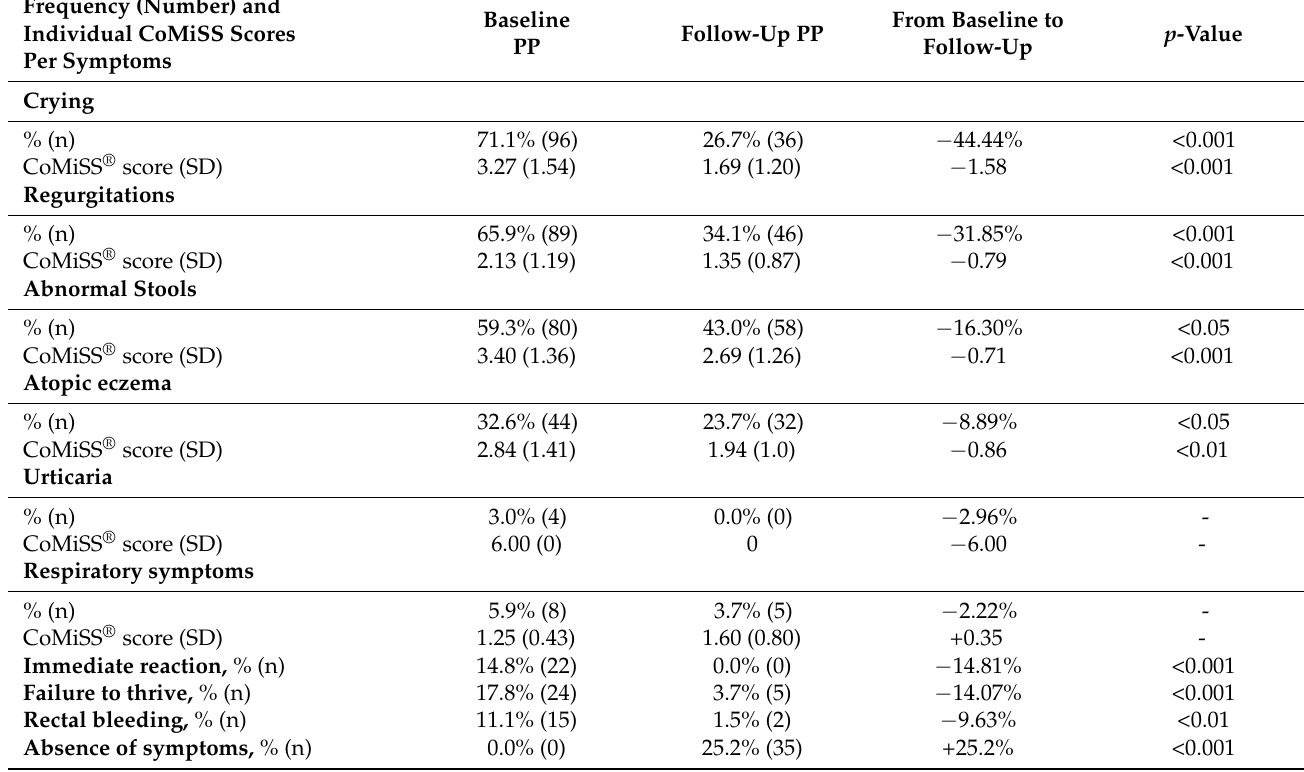
Table 2. Frequency of symptoms and CoMiSS ® score per symptom at baseline and